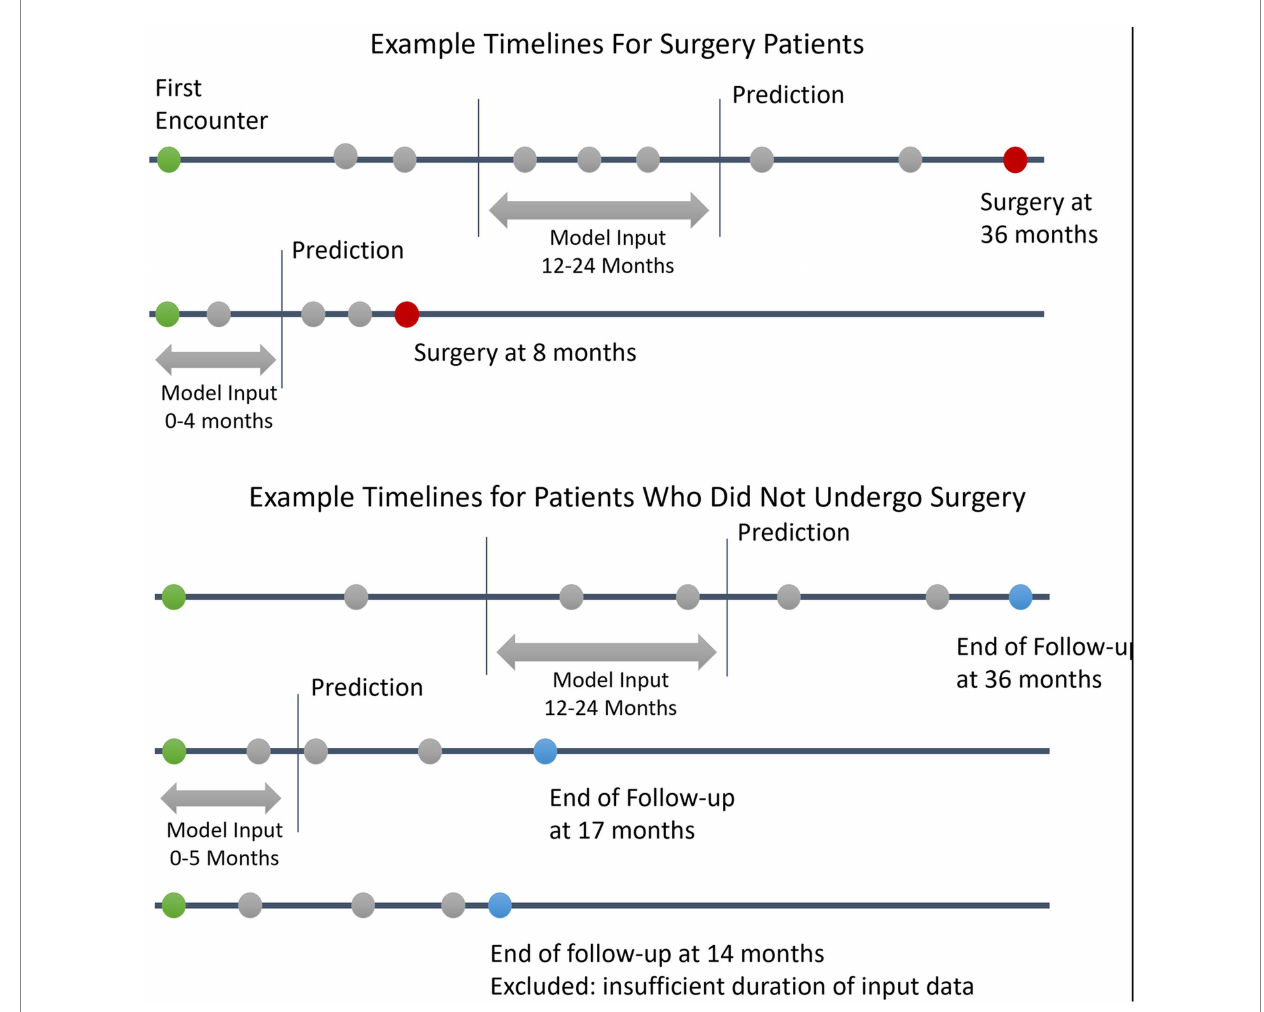
FIGURE 1 Example Patient Electronic Health Records Timelines. This figure depicts example timelines of patients who did and did not progress to glaucoma surgery. Green circles represent the first patient encounter. Red circles represent surgery dates. Blue circles represent the last follow-up encounter for patients who did undergo surgery. Grey circles represent other encounters with associated clinical data in the electronic health